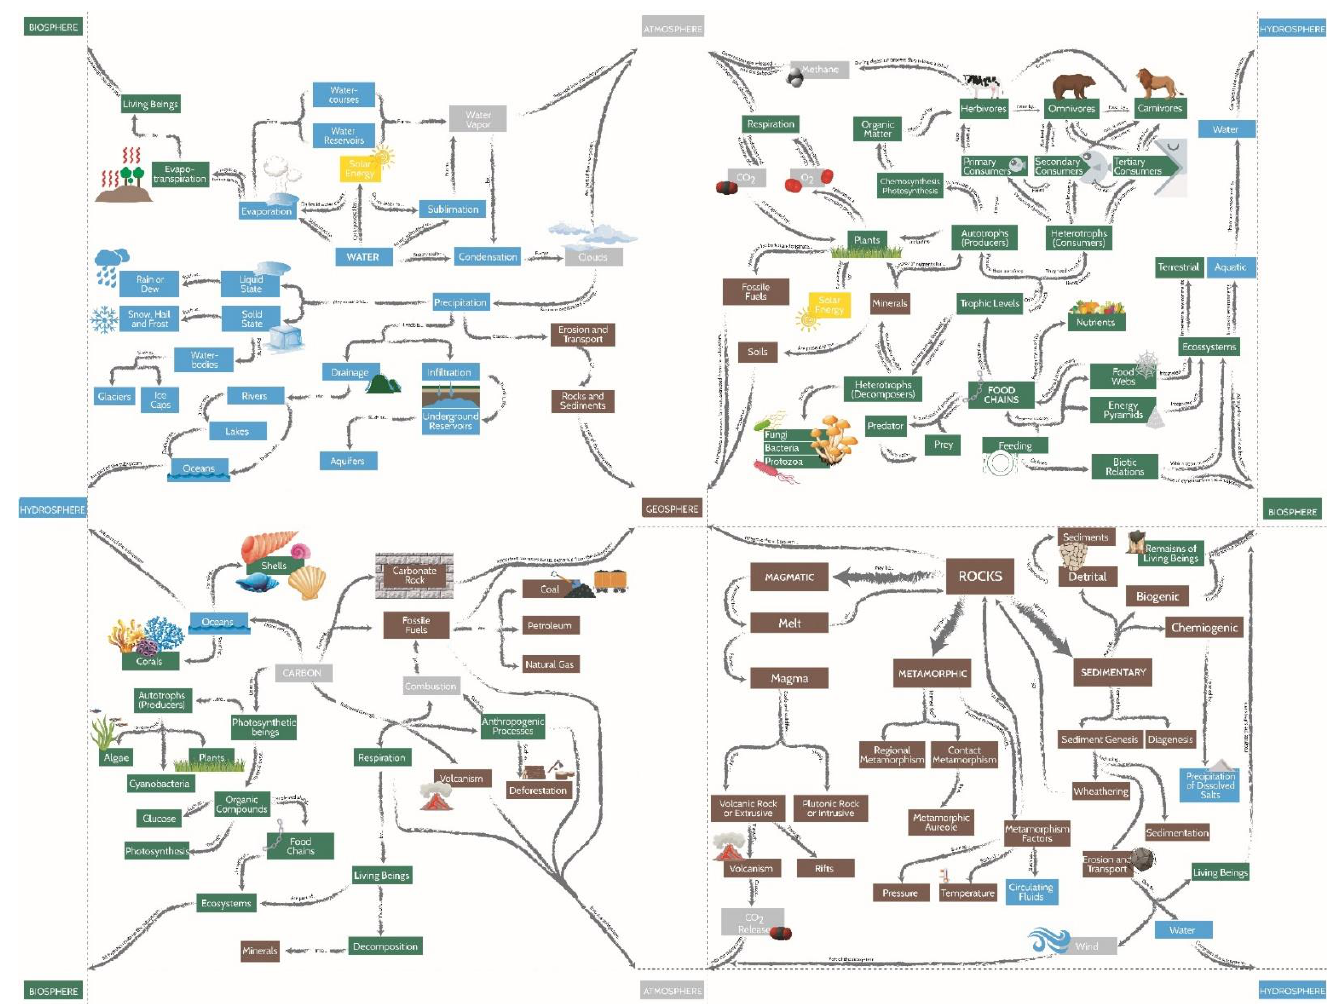
Figure 2. The research team reference map used to evaluate student’s performance.